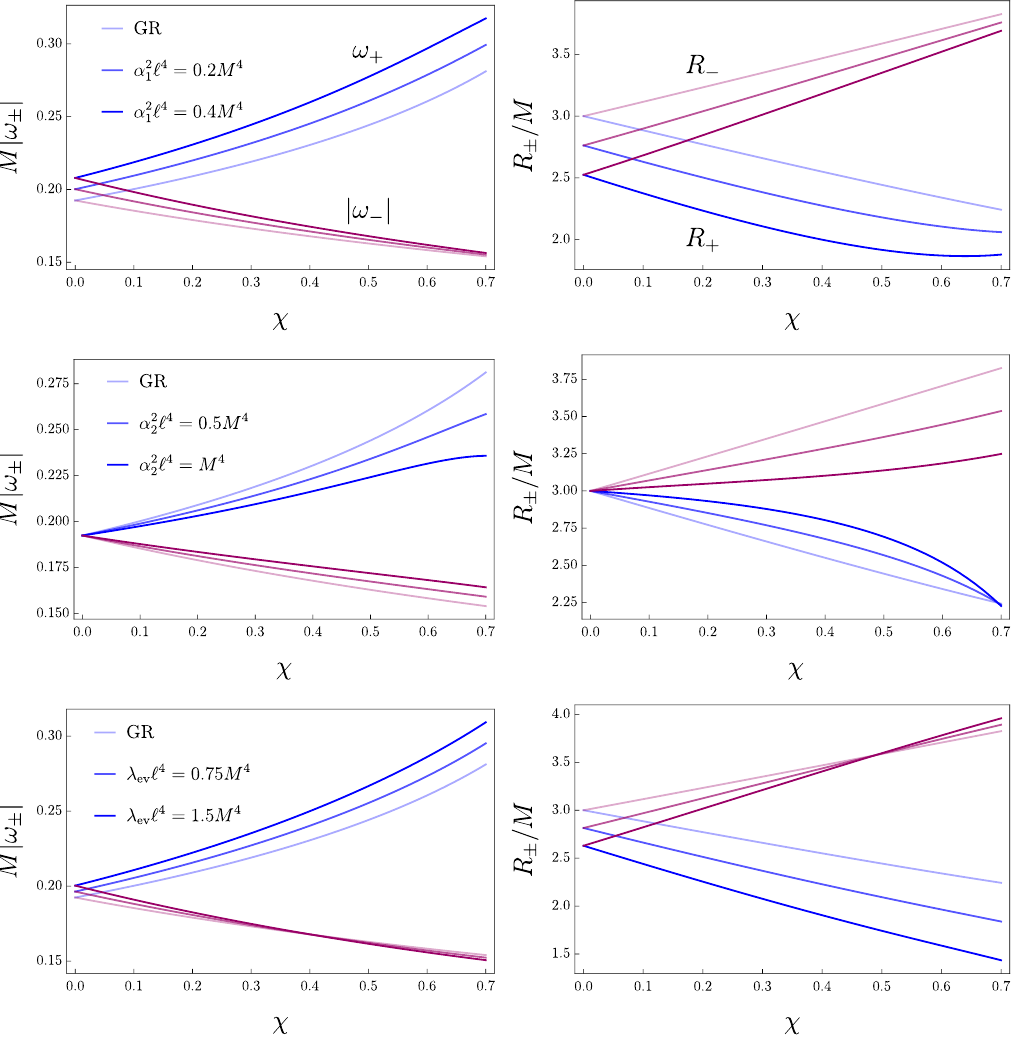
Figure 8 . Frequencies and radii of the light rings in parity-preserving theories. In blue we plot the quantity corresponding to the prograde orbit and in purple that corresponding to the retrograde one. In the left column we show the frequencies for di(cid:11)erent values of the couplings and compare them to GR. In the right column we plot the radii R (cid:6) for the same values of the